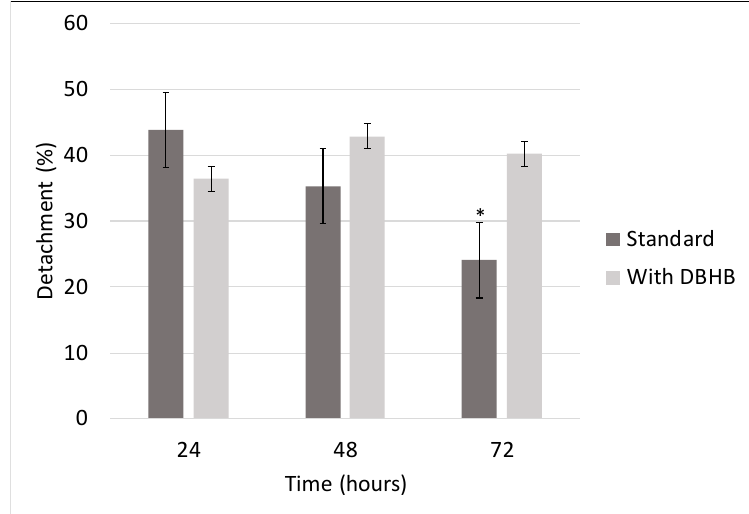
Figure 5. Impact of DBHB (16 μ M) on detachment of C. closterium after 24, 48 and 72 adhesion. Data represent the mean ± standard deviation of replicates; * statistically significant difference at the 95% confidence level between standard (without DBHB) and treated samples.